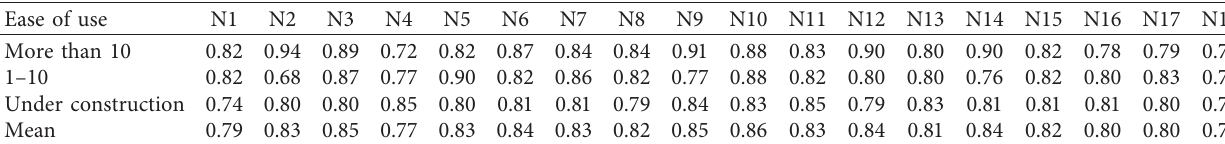
Table 8: The ease of use score of each BIM application area.